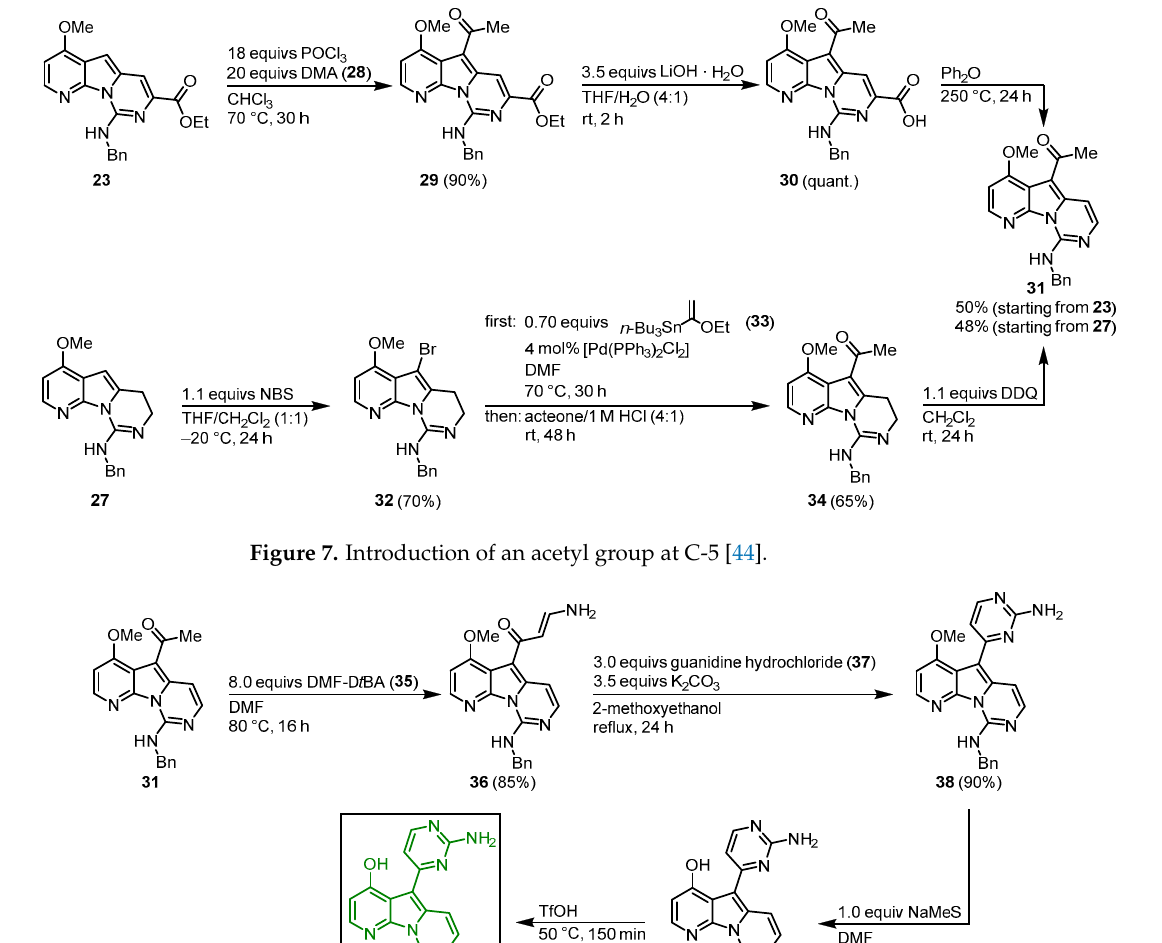
Figure 8. Synthesis of the 2-aminopyrimidine ring to give access to variolin B ( 1 ) [44].